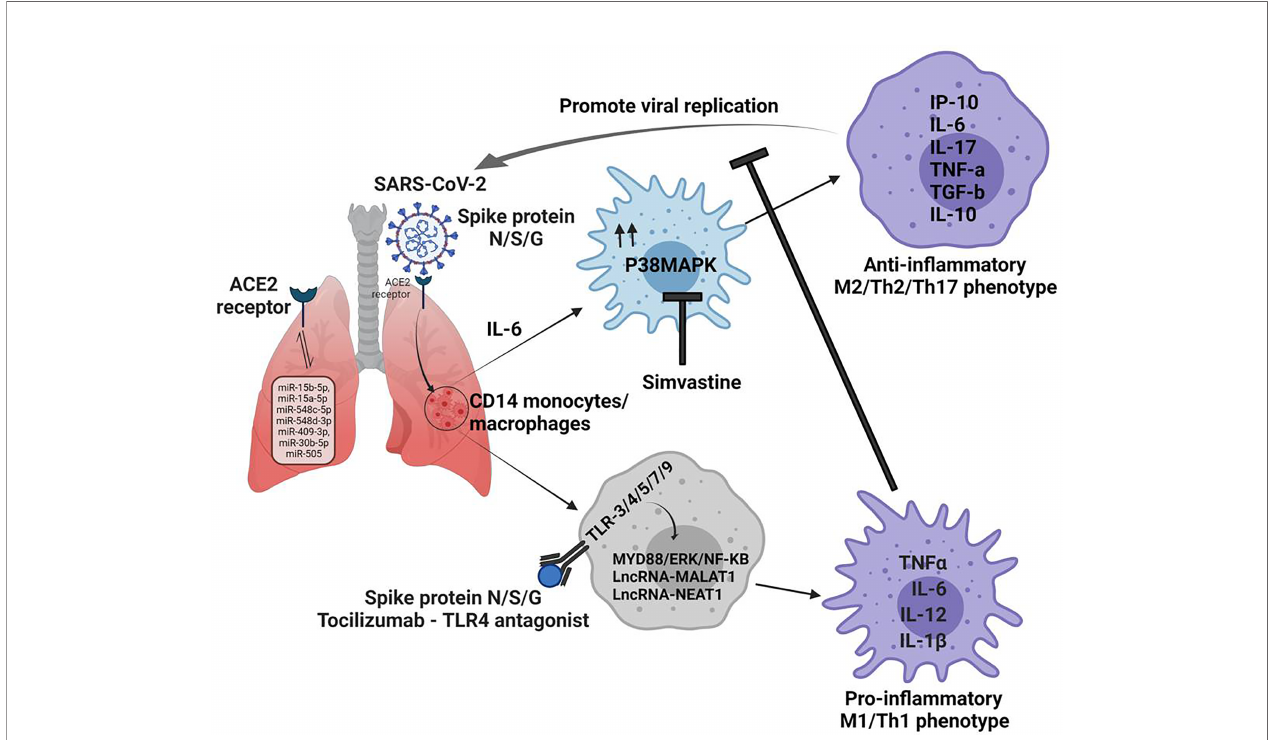
FIGURE 1 | Non-coding RNAs regulates macrophage plasticity duringthe pathogenesis of Covid 19 disease. 1. N/S/Gspike proteins bind to ACE2 receptors onlungcells anddetermine the entryof the SARS-CoV-2 virus. 2. miRNA can bedirect targets since they can regulate the expression ofACE2 in variousorgans. 3. Infection produces an copiusamount ofIL-6, which drives the fate of CD14 monocytes/macrophages towards M2phenotype via MAPKsignaling, which promotes viral replication.4. In view of this virus eliminating in fl ammatoryniche could beachievdby promting M1phenotypein TLRdepenedent MYD88/ERK/NF-Kb pathway.5. This could befosterdby application of MAPKinhibitors likesimvastatin inconjuction ofTLR antagonist which can helpimmune cells to curb SARS-CoV-2 in the